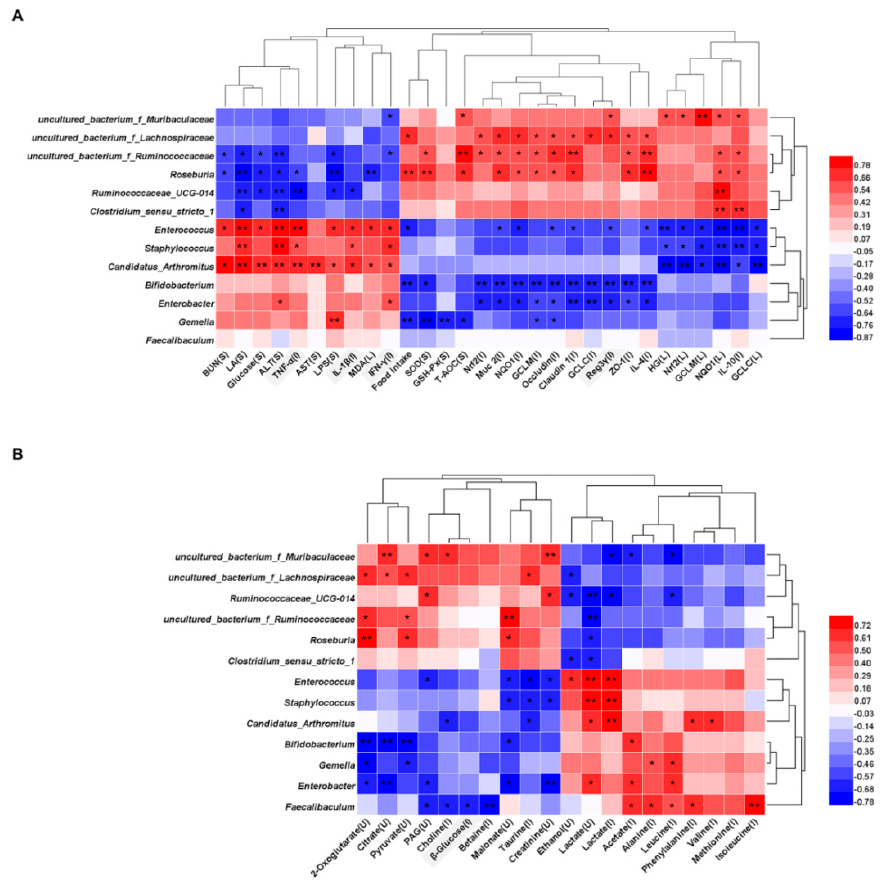
Figure 5. Correlation analysis between small intestine microbiota (genus level) reversed by FDB intervention with fatigue related parameters and metabolites. Correlation of 13 genera with ( A ) fatigue related parameters and ( B ) urinary and small intestine metabolites. The heat map represents the cor- relation coefficient value. The parameters and metabolites for the serum, liver, ileum and urine were labeled as S, L, I, and U, respectively. Significant correlations are marked by * p < 0.05, ** p < 0.01. To further investigate the potential associations between altered small intestine